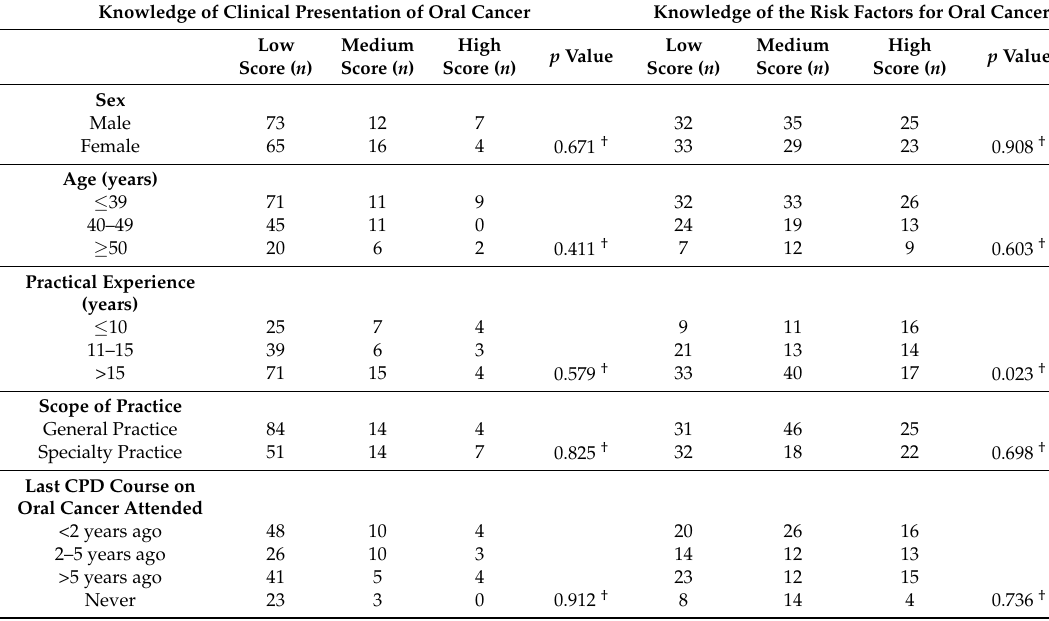
Table 3. Association between dentists’ personal characteristics and knowledge of the clinical presentation of and risk factors for oral cancer ( n =